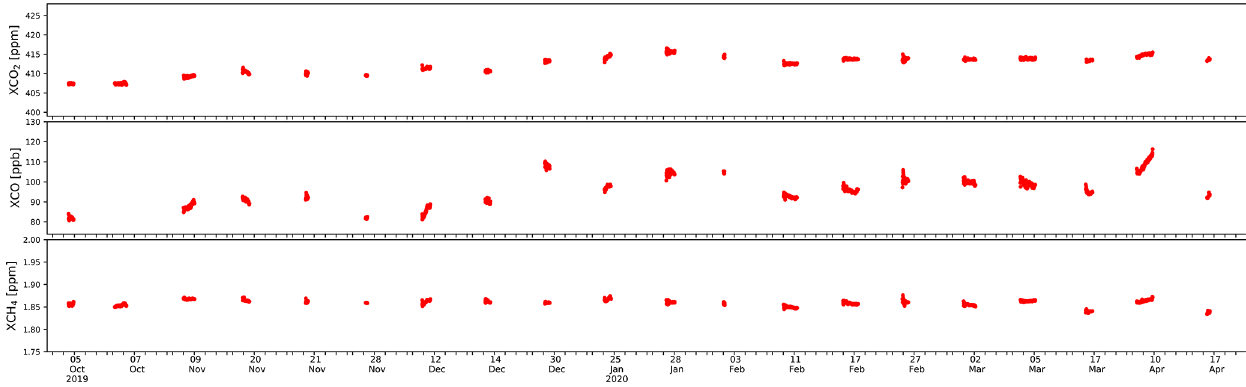
Figure 7. Time series of XCO 2 , XCO and XCH 4 data observed at Yekaterinburg.